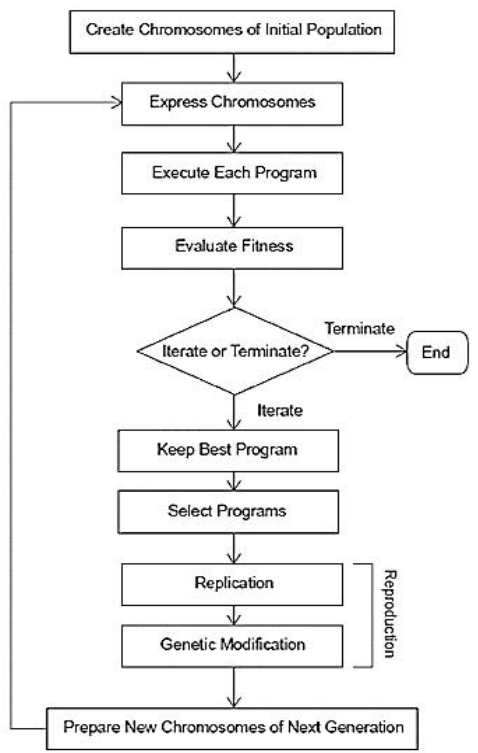
Fig. 3: The flowchart of a gene expression algorithm (Ferreira,